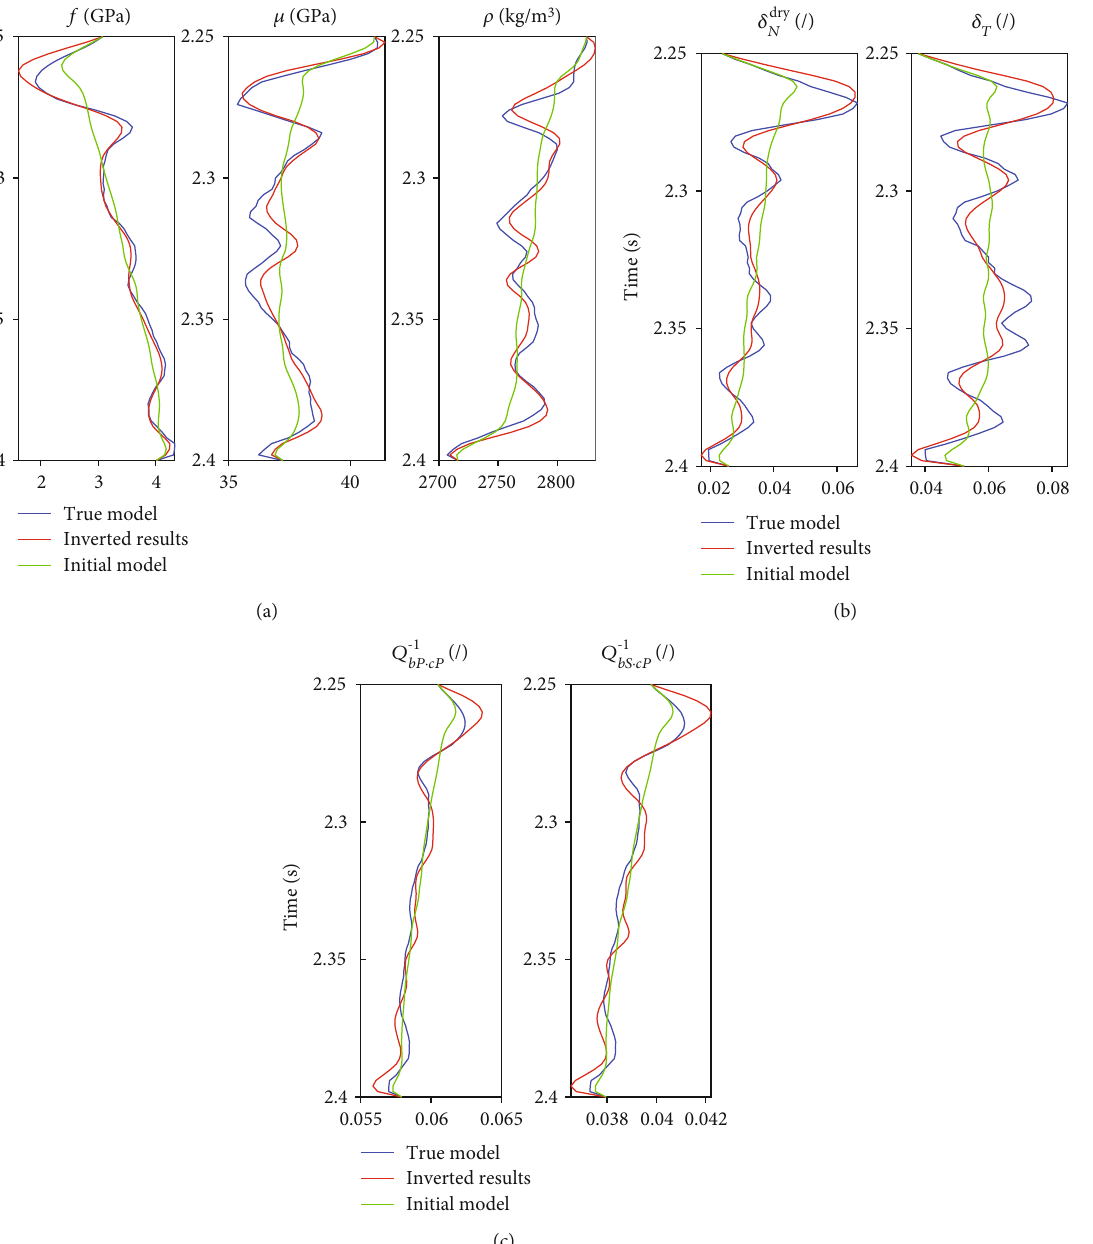
Figure 3: Estimated model parameters using the azimuthal attenuation EI inversion with SNR being 5, where (a) shows the fl uid/porosity term, shear modulus, and density; (b) shows the normal and tangential fracture weaknesses; and (c) shows the attenuation